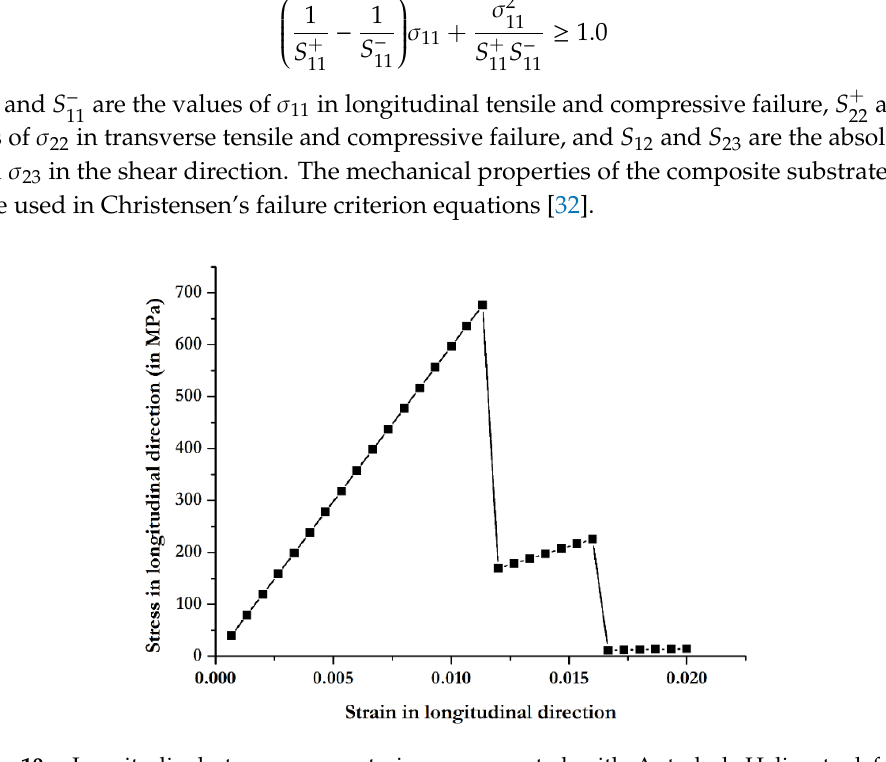
Figure 10. Longitudinal stress versus strain, as computed with Autodesk Helius tool for the composite substrate.